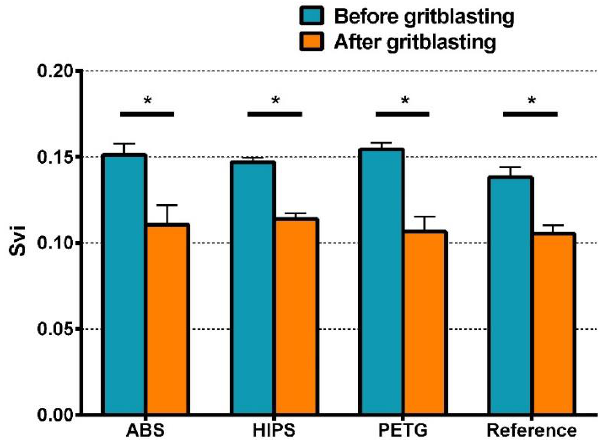
Figure 8. Svi values of all material groups before and after GB (Mean ± SD, n = 3). * represents statistically significant differences in Svi of all groups before and after GB.